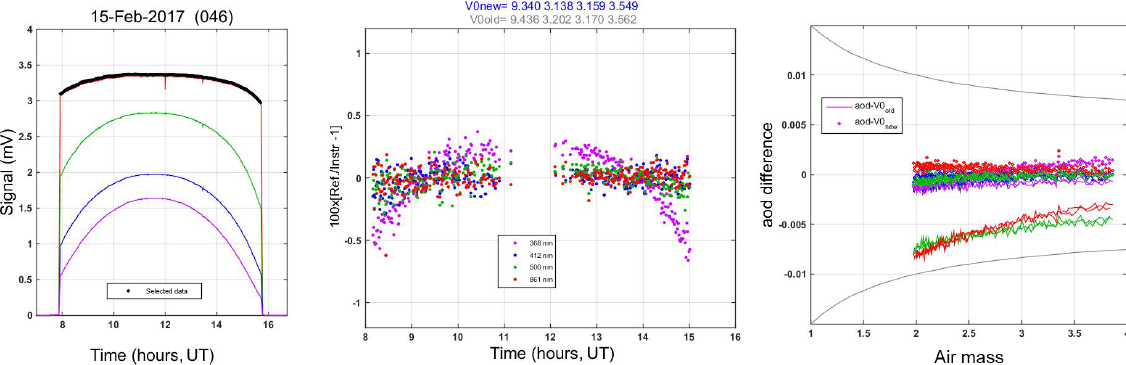
Figure 5. Calibration of an instrument against the triad: (a) measurement signals at four wavelengths, (b) comparison of instrument signals, (c) differences between instrument- and triad-retrieved AOD using the old and the new calibration V 0 xR .